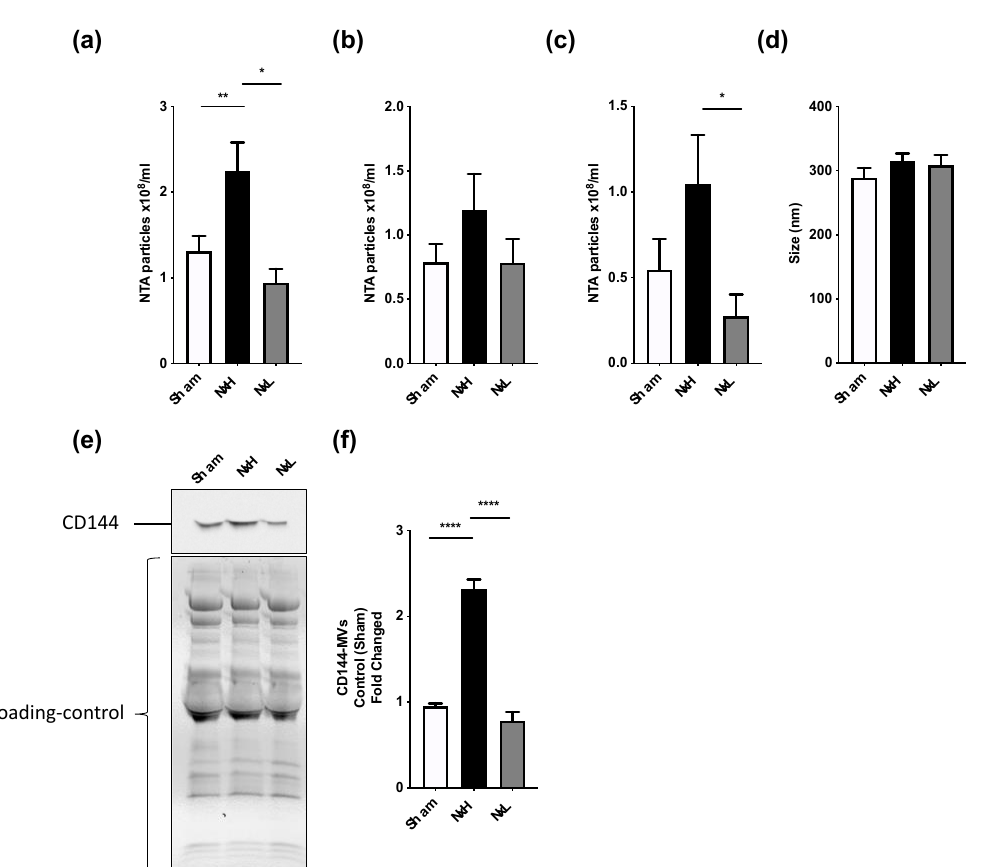
Figure 2. Hyperphosphatemia induces release of endothelial microvesicles (MVs). ( a – d ) Count and size range of MVs as measured by nanoparticle tracking analysis (NTA). ( a ); Total MVs, ( b ); MVs sized between 100–1000 nm, ( c ); 10–100 nm diameter particles, ( d ); particle size. ( e , f ) Representative Western blot results and densitometry analysis, respectively, showing the presence of CD144 + endothelium-derived MVs within isolated plasma MVs. Sham denotes control rats subjected to bilateral kidney decapsulation and receiving a high (1.2%) phosphorus diet for 14 days after two weeks’ recovery from the surgery. NxH denotes partially nephrectomised rats receiving a high (1.2%) phosphorus diet for 14 days after two weeks’ recovery from the surgery. NxL denotes partially nephrectomised rats receiving a low (0.2%) phosphorus diet for 14 days after two weeks’ recovery from the surgery. n = 12; (12 rats in each study group), * p < 0.05, ** p < 0.005, **** p <